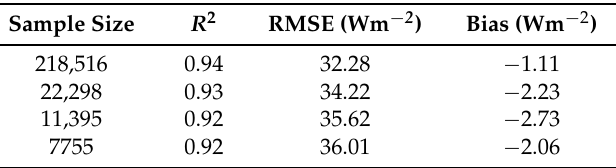
Table 5. Fitting accuracy in SVR with different sample